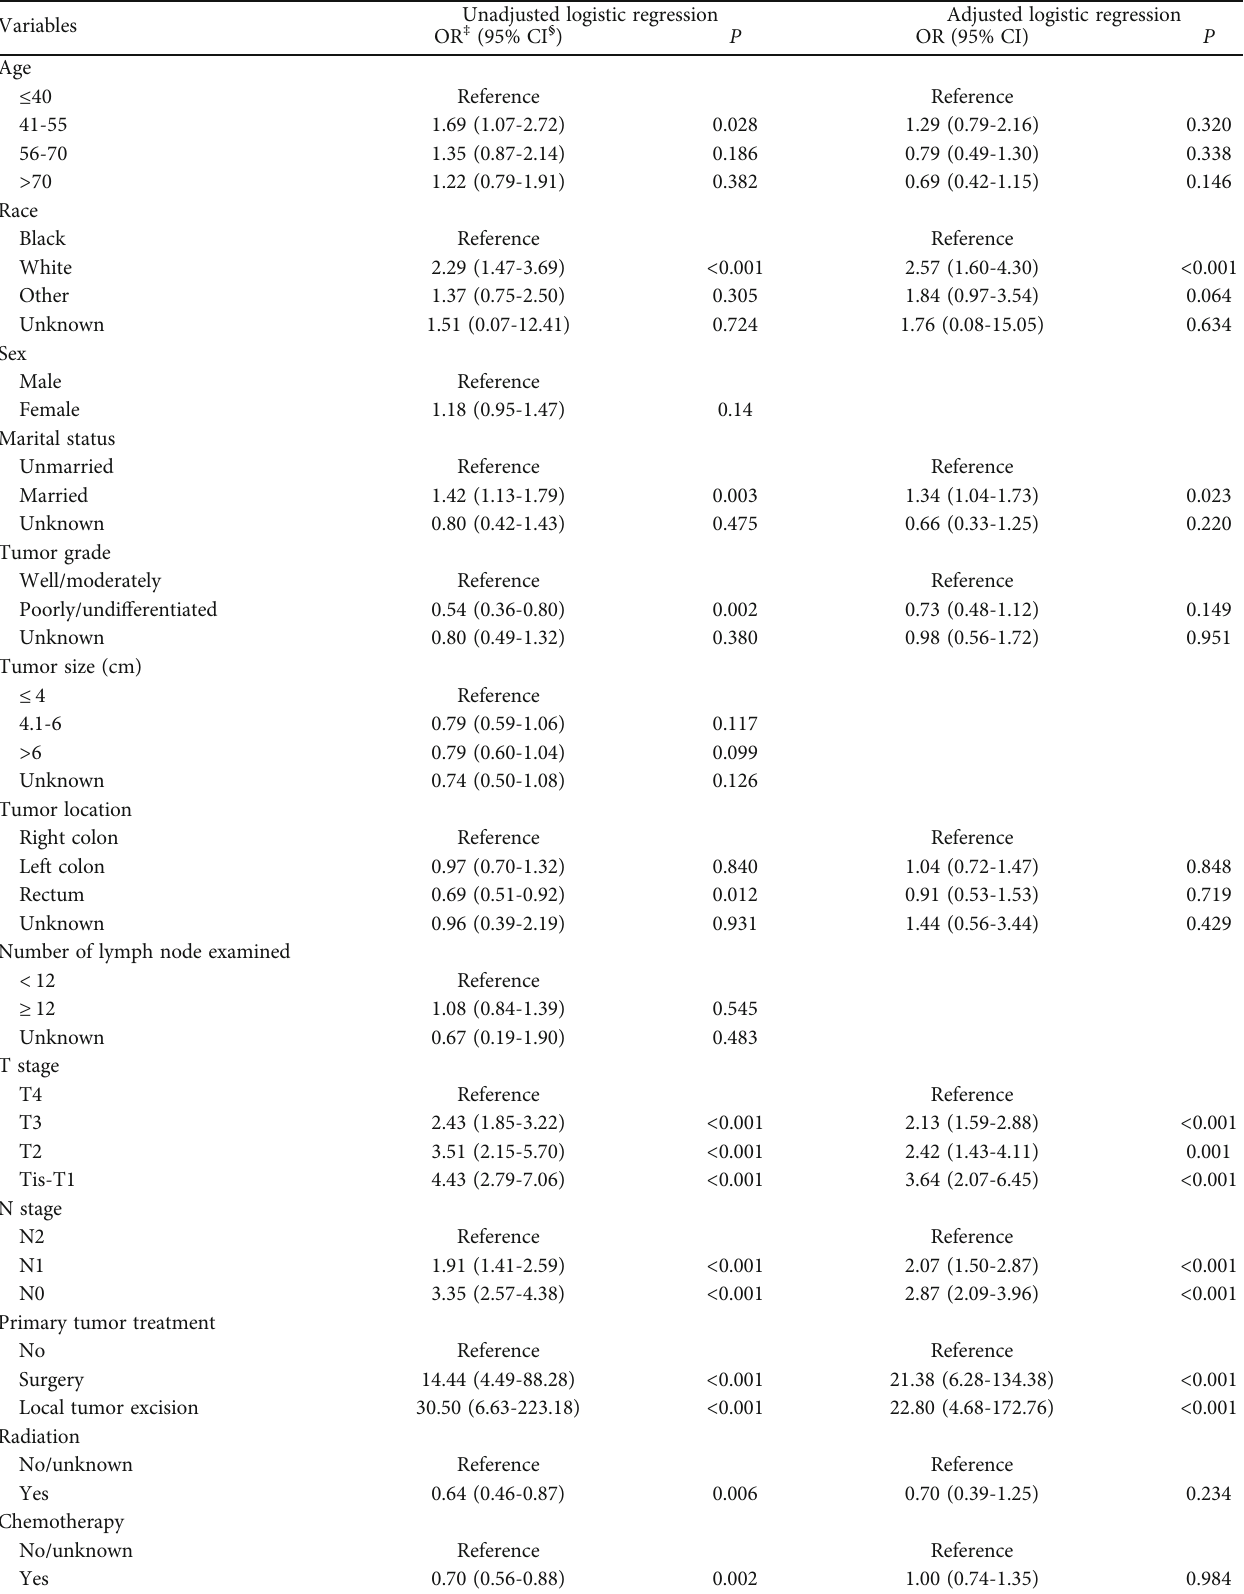
Table 2: Logistic regression analysis to identify predictors of long-time survivors in nonmetastatic colorectal SRCC † in the training